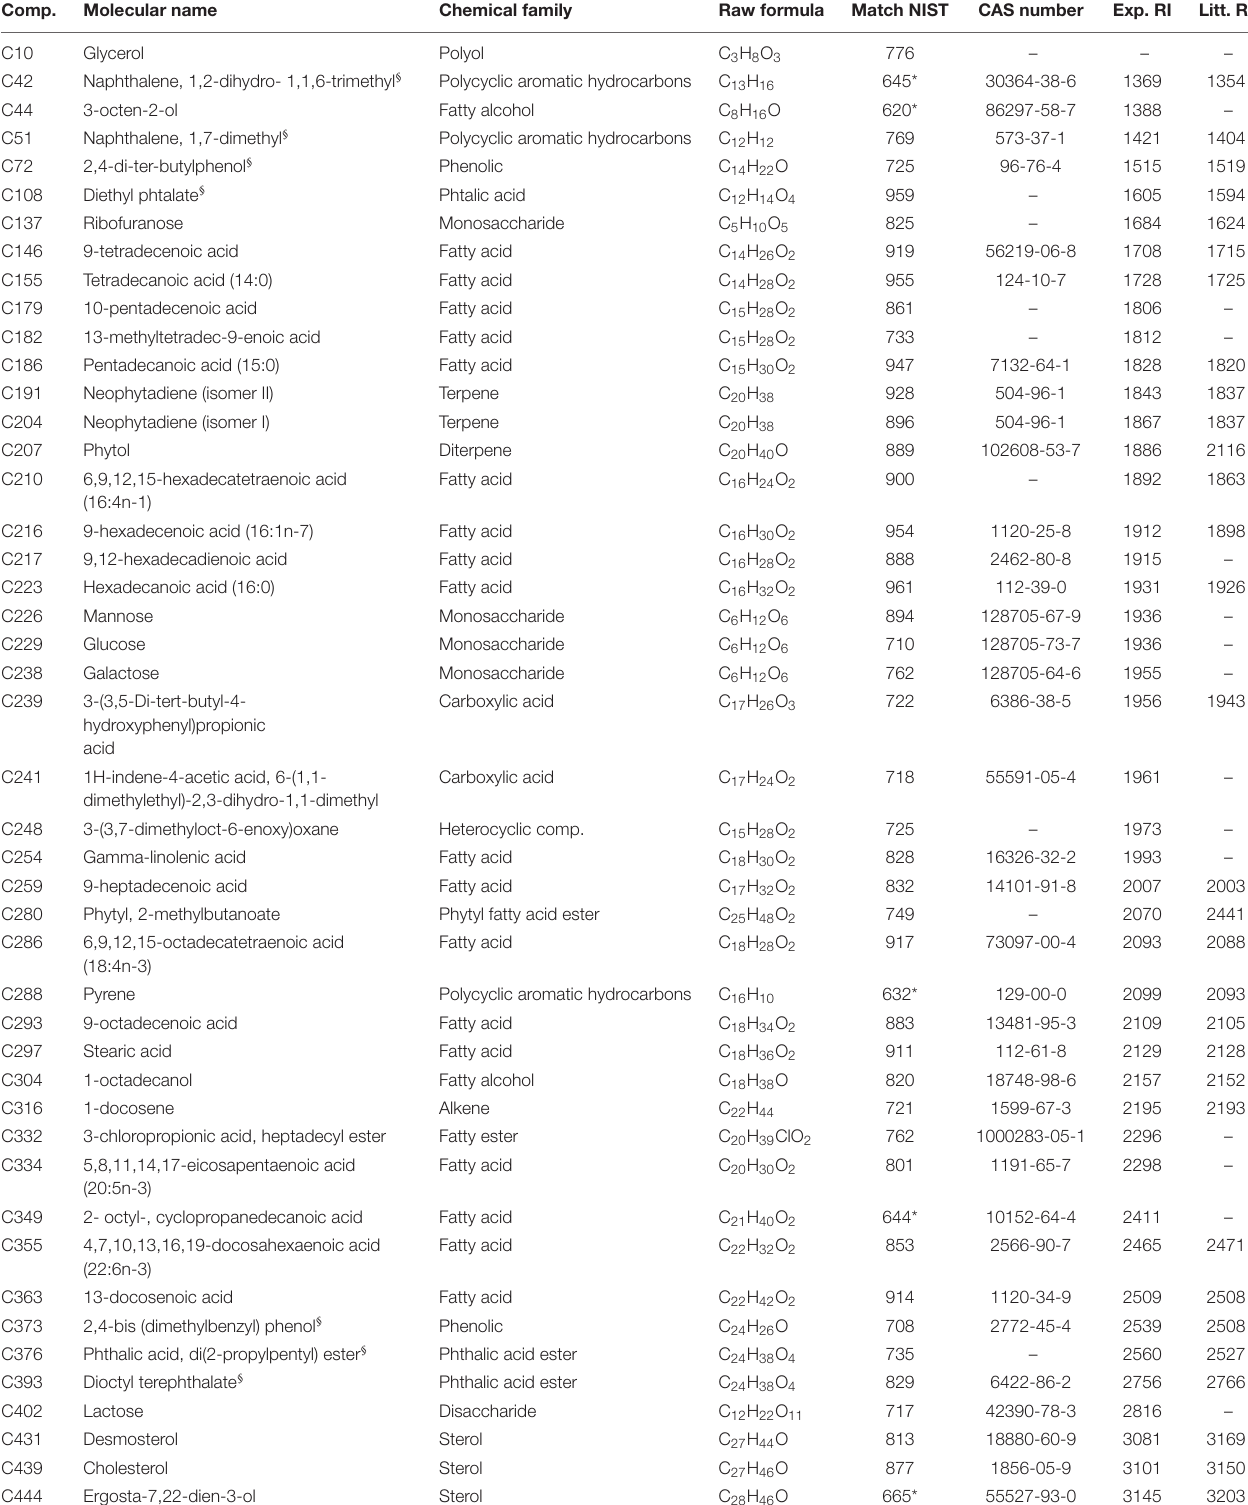
TABLE 3 | Annotated compounds in the MeOH fraction of the MPB biofilm during the light exposure experiment (after data analyses and filtering).